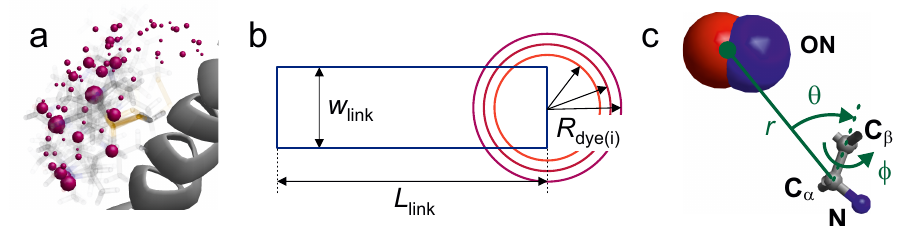
Figure 6. Representation of labels in modelling approaches ( a ) Rotamer library representation (MMM). Rotamer population is encoded by transparency and by the volume of the purple spheres that represent the N-O group midpoint of rotamers. ( b ) Accessible volume model parametrized by a linker length L link , a linker width w link , and a set of three dye radii R dye ( i ) . Adapted from [57] ( c ) Coarse-grained rotamer model based on a dummy ON particle, which represents the midpoint of the N-O group. Each rotamer is defined by a distance r from the C α atom and two angles that relate the label position to the C α -C β bond. Adapted from